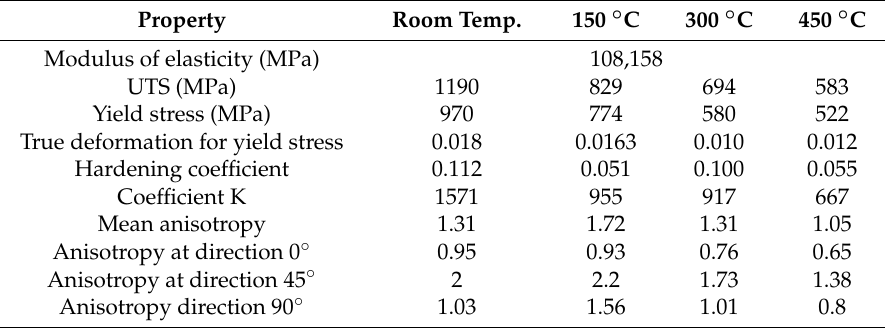
Table 1. Mechanical properties of Ti6Al4V